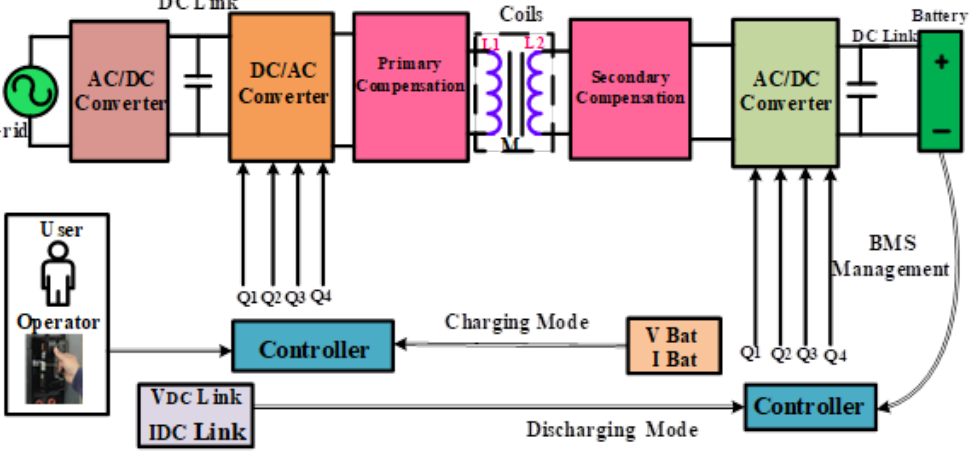
Figure 1. Functional diagram of Bidirectional Wireless Power Transfer.